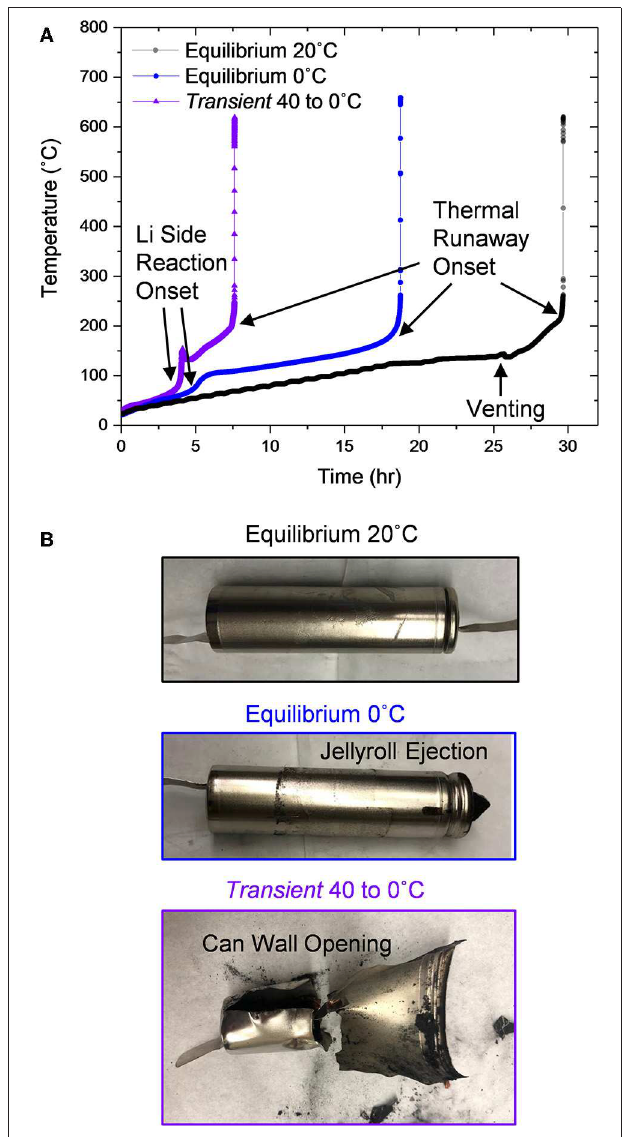
FIGURE 8 | (A) Cell temperature over time during accelerating rate calorimetry (ARC) testing and (B) photographs of each cell after ARC